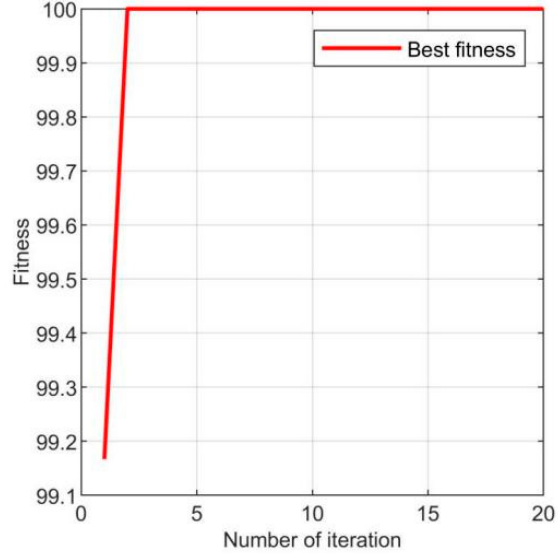
Figure 10. The convergence curve of the SOA-SVM method.